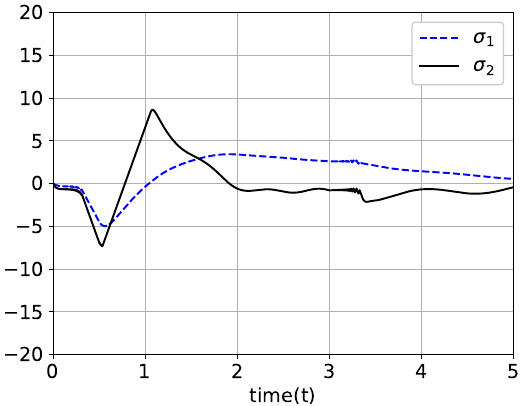
Figure 23. For the proposed HOSD: trajectories of σ 1 and σ 2